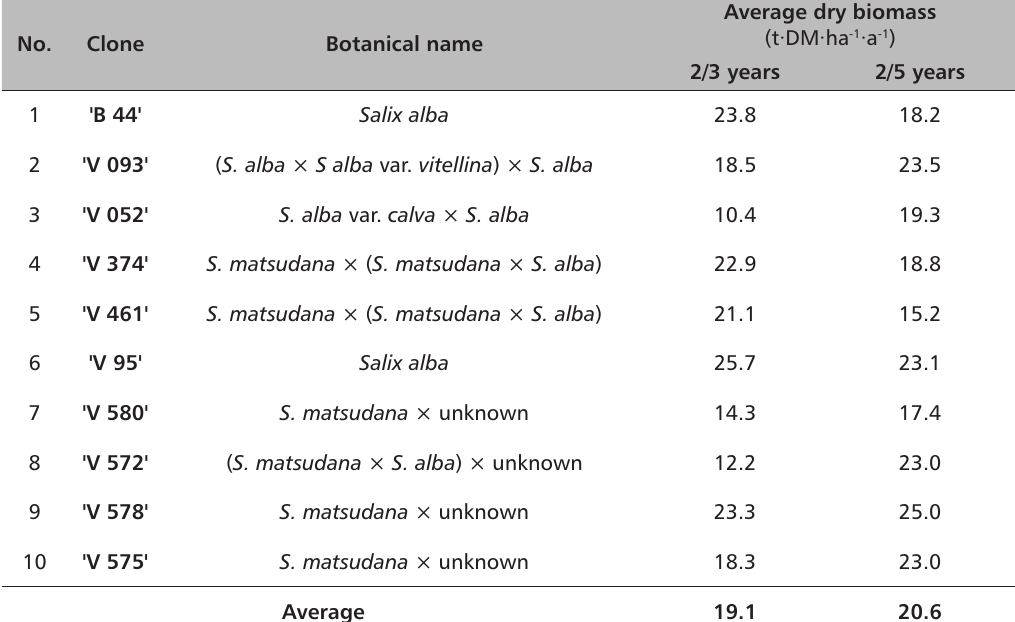
tABLE 2. Average biomass production of tested willow clones (Valpovo test)